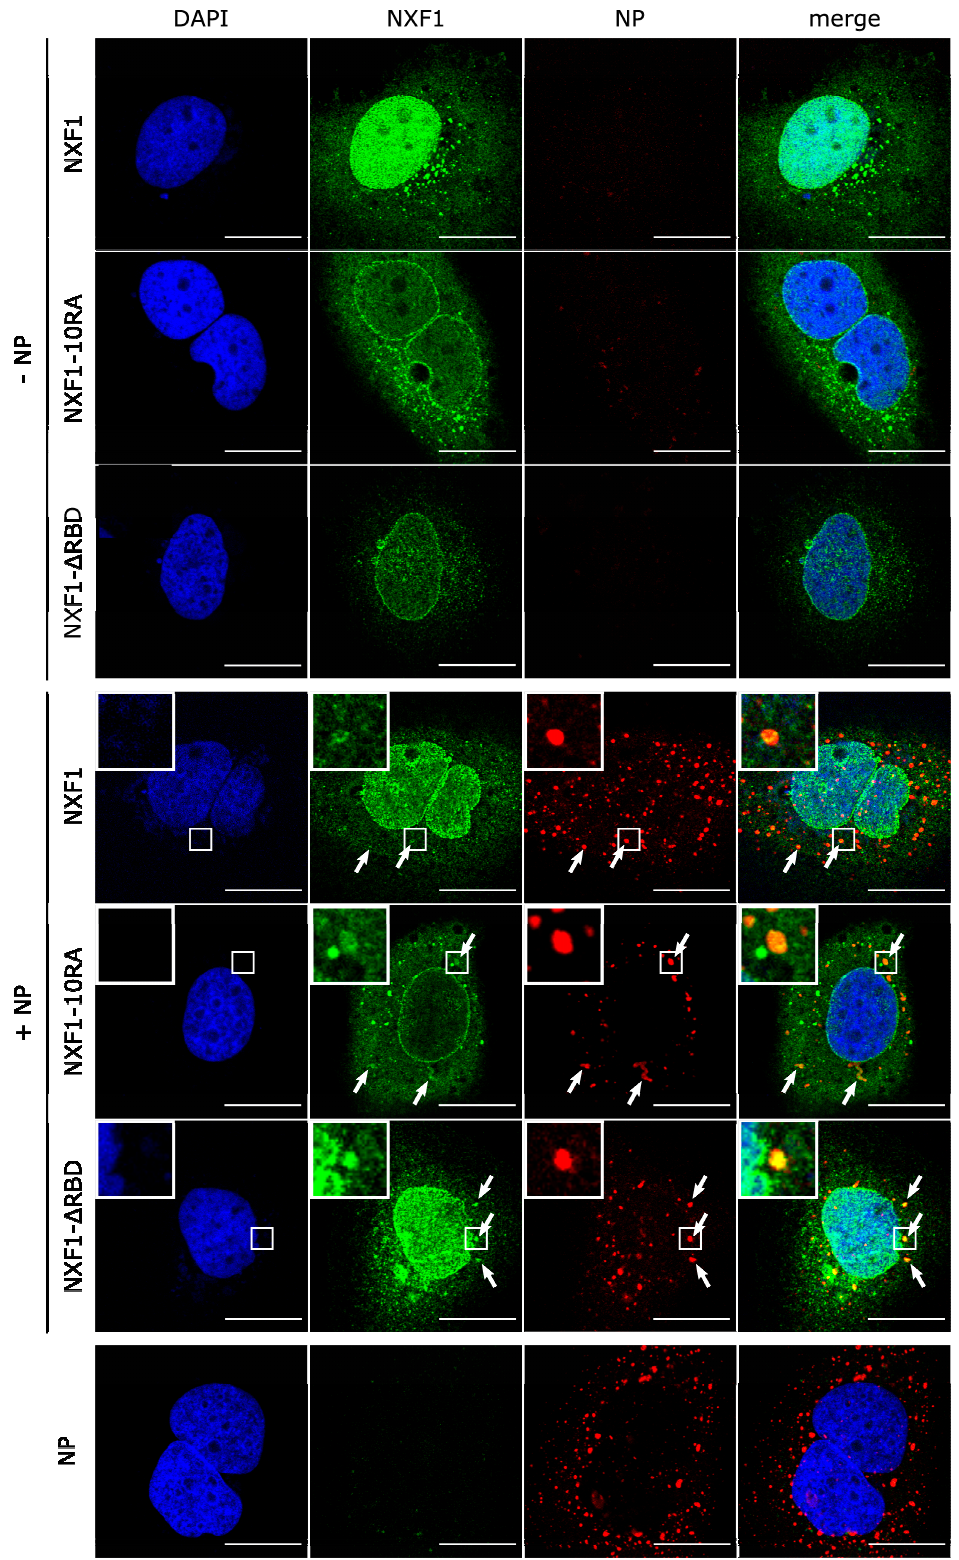
Figure 5. Recruitment of NXF1 into NP-derived inclusion bodies. Huh7 cells were transfected with plasmids encoding flag/HA-NXF1, flag/HA-NXF1-10RA or flag/HA-NXF1- Δ RBD together with NP as indicated. Forty-eight hours p.t., cells were fixed with 4% PFA and permeabilized with Triton X-100. NXF1 (shown in green) was detected with anti-flag antibodies and NP (shown in red) with anti-NP antibodies. Nuclei were stained with DAPI (shown in blue), and cells were visualized by confocal laser scanning microscopy. Scale bars indicate 20 µ m. Arrows point out colocalization, and insets show magnifications of indicated